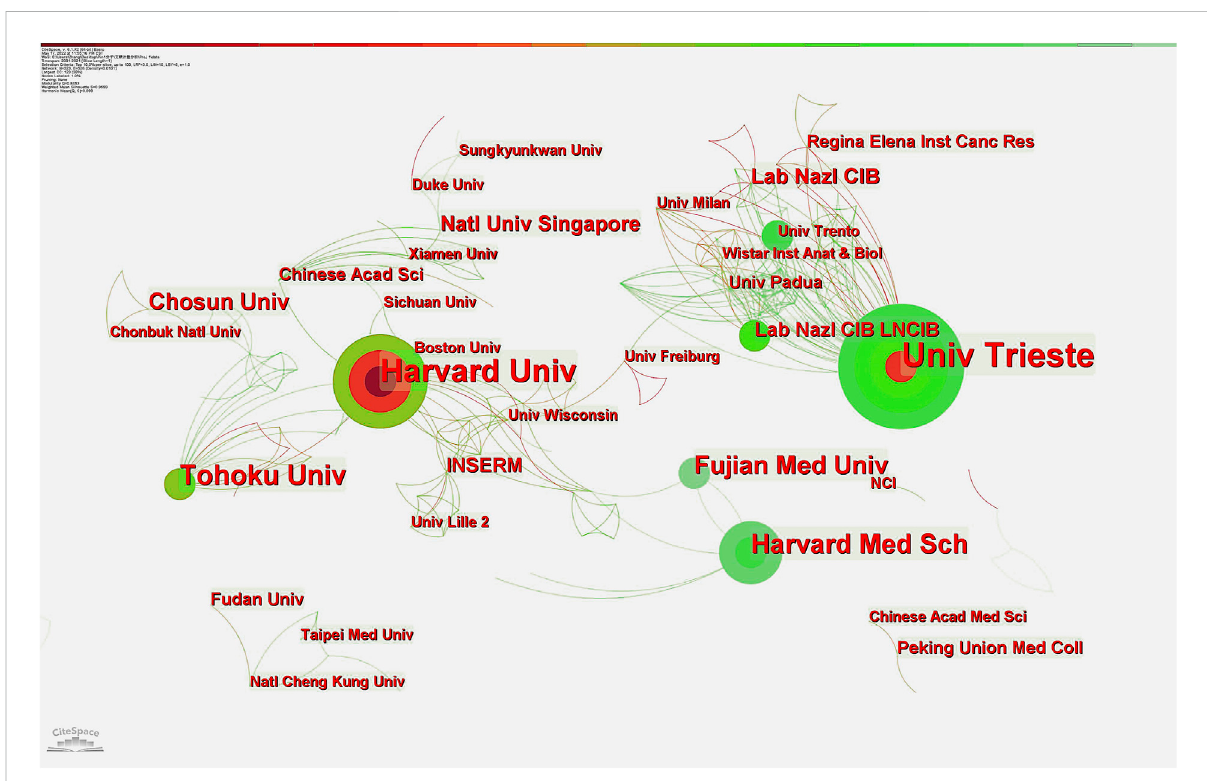
FIGURE 5 Distribution of publications from different institutions. Harvard University and the University of Trieste are tied for fi rst place in the number of publications, with Harvard having the strongest centrality. These two core agencies have more cooperative links with most other institutions.